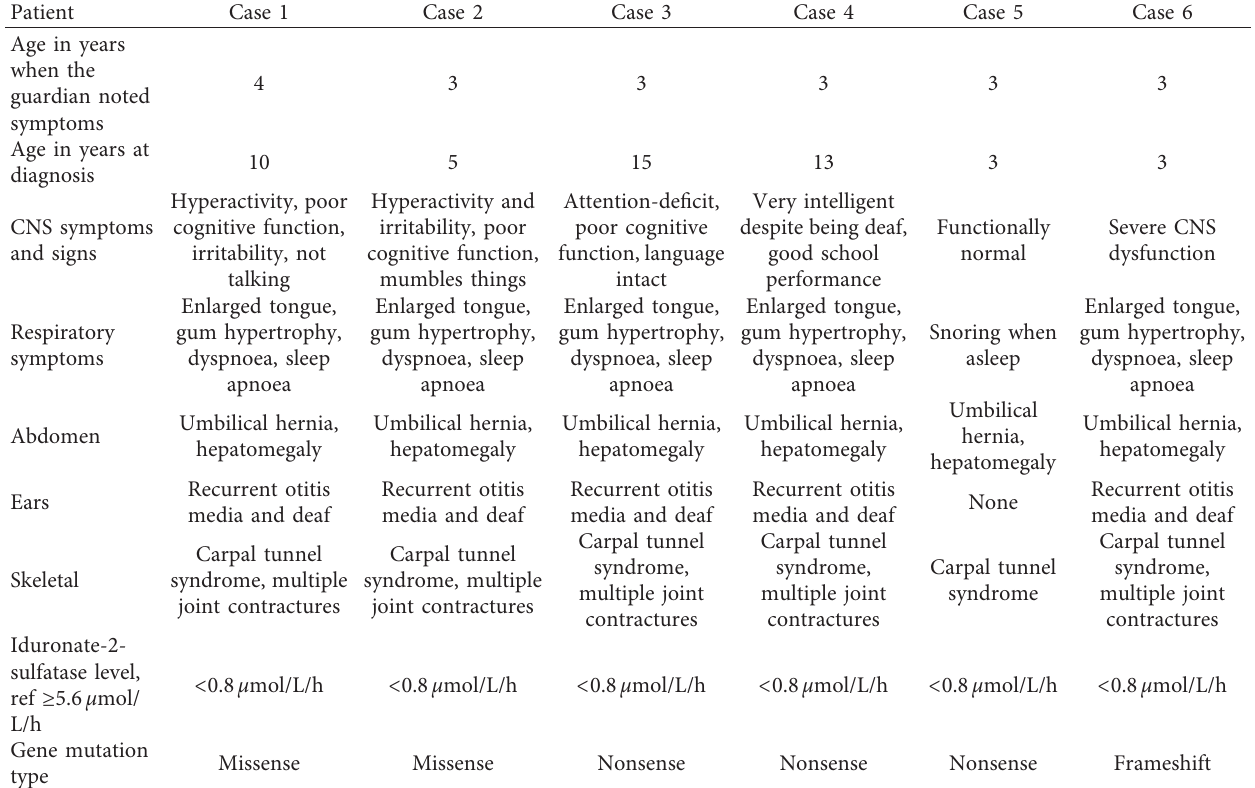
Table 1: Clinical characteristics of mucopolysaccharidosis type II patients at Kenyatta National